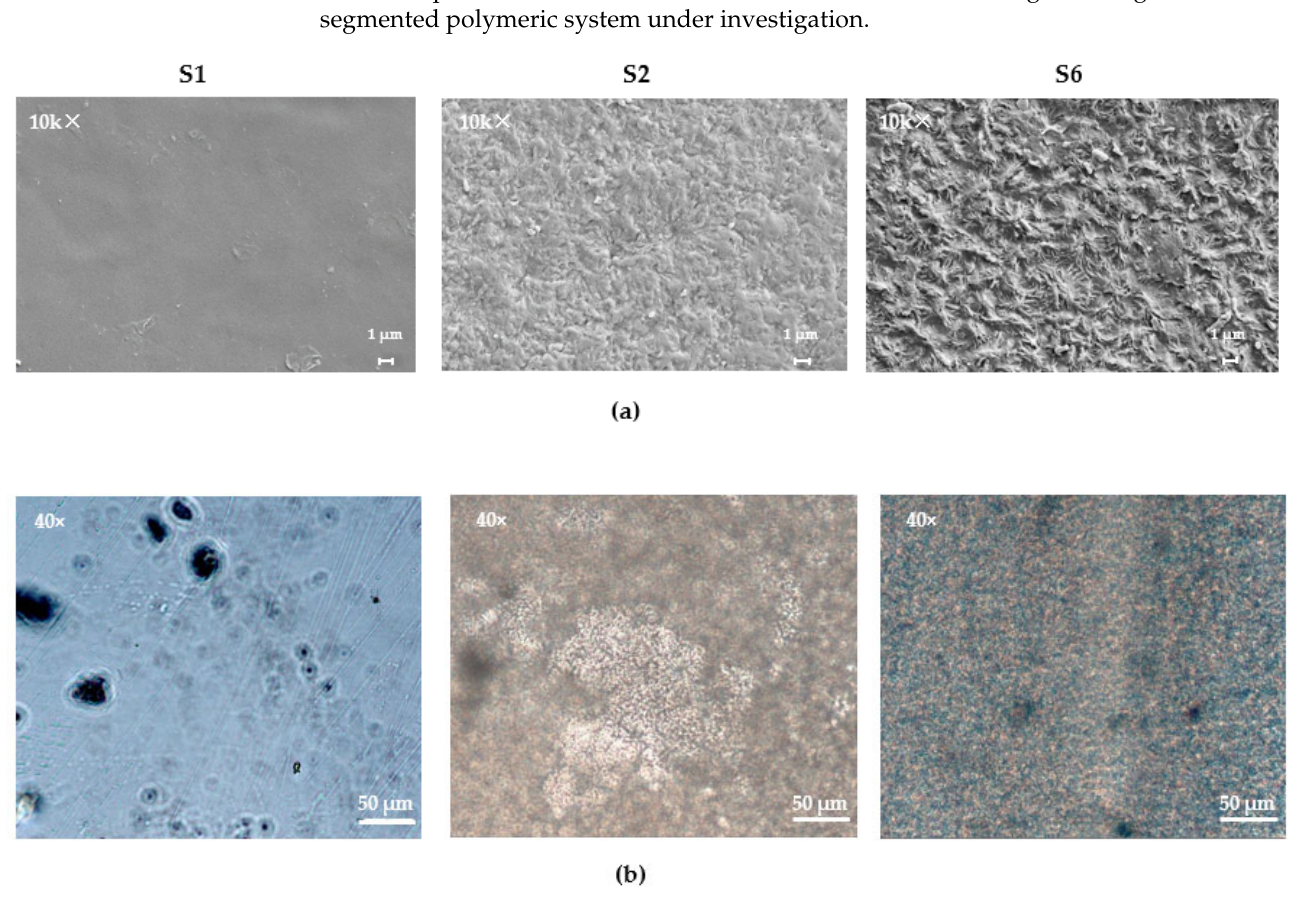
Figure 10. SEM micrographs ( a ) and POM images ( b ) of segmented PUU of the compositions S1, S2, and S6.